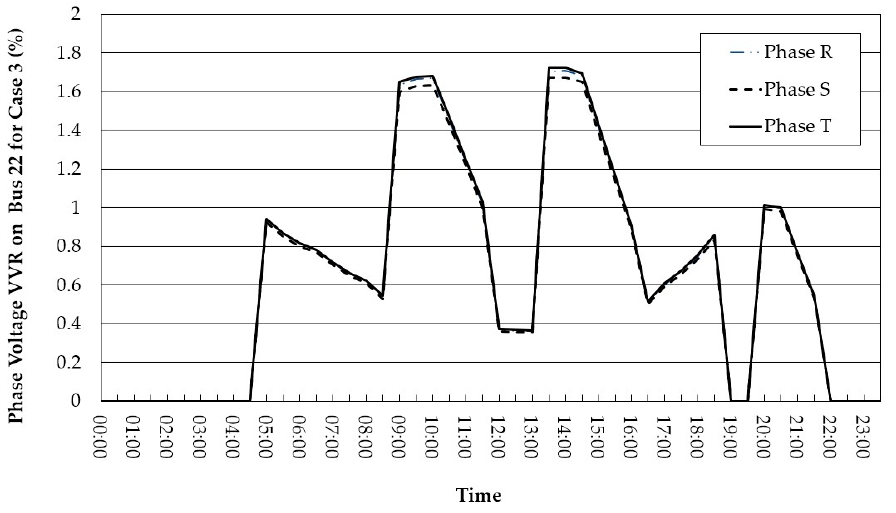
Figure 20. Three-phase VVR variation on Bus 1 for Case 3.